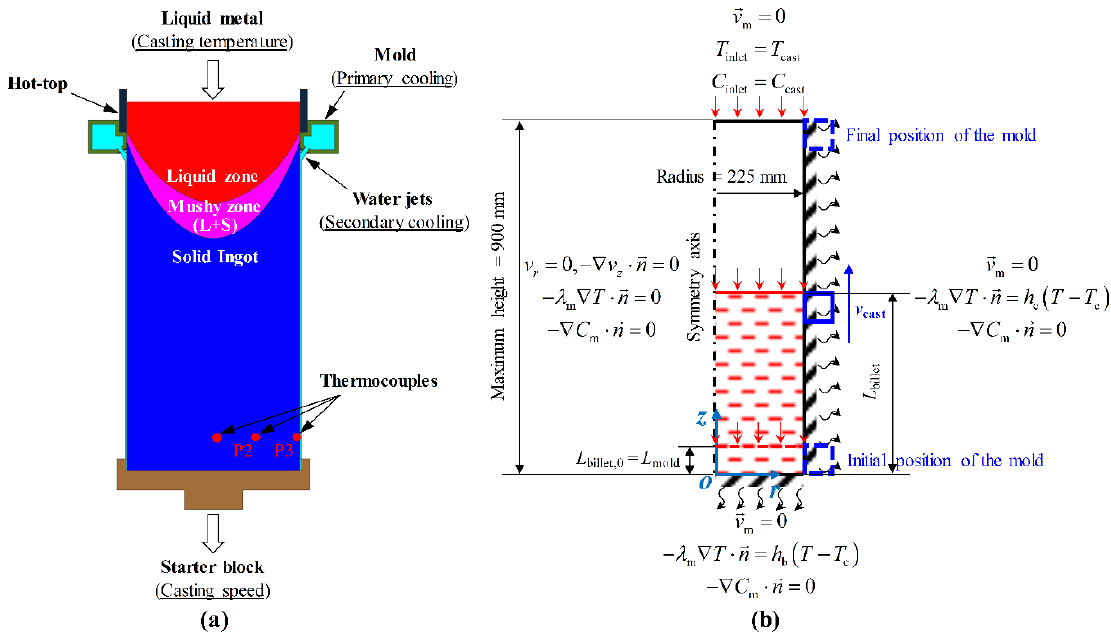
Figure 1. Physical model used in present simulations: ( a ) schematic of a hot-top DC casting process, and ( b ) 2D axisymmetric model with a Lagrangian representation.